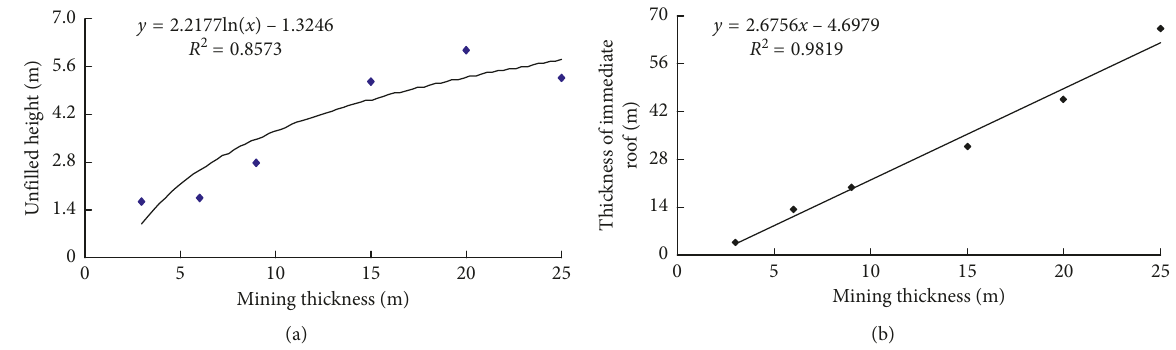
Figure 2: The relation between the unfilled height, thickness of immediate roof which needs to be controlled, and the mining thickness. (a) Unfilled height and mining thickness. (b) Thickness of the immediate roof which needs to be